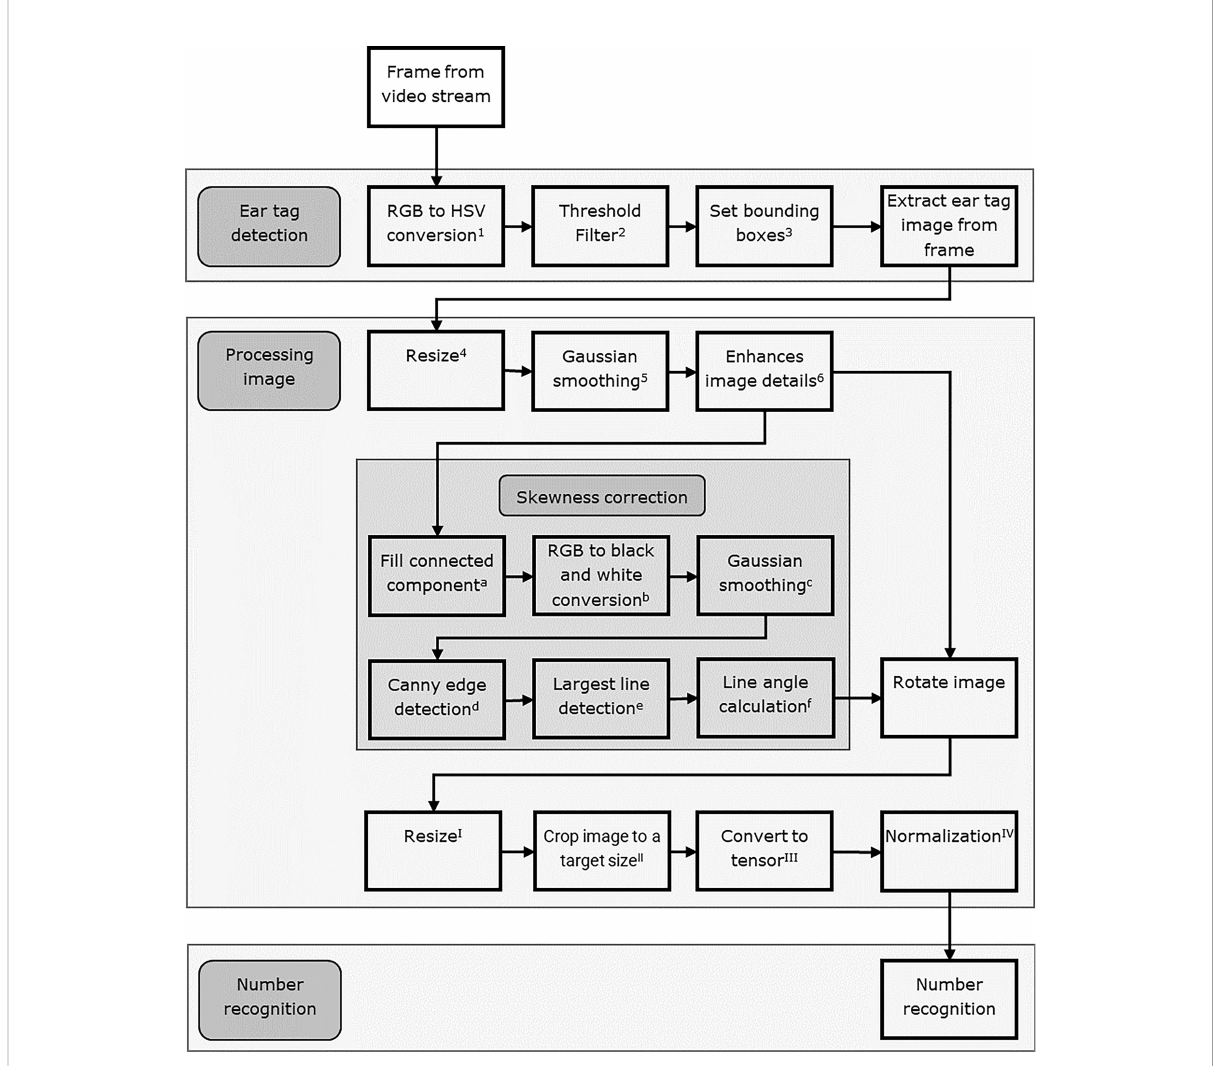
FIGURE 1 Steps in ear tag recognition algorithm. Applied functions (openCV python): 1 cvtColor(frame, cv2.COLOR_BGR2HSV), 2 inRange(frame, [22, 95, 90], [40, 255, 255]) and threshold(image, 127, 255, 0), 3 fi ndContours(frame, cv2.RETR_TREE, cv2.CHAIN_APPROX_SIMPLE), 4 resize(crop_img, dim, interpolation = cv2.INTER_LINEAR), 5 GaussianBlur(image, (5, 5), 0), 6 detailEnhance(image, sigma_s = 20, sigma_r = 0.10), a fl oodFill(image, [height + 2, width + 2], (100, 100), (0, 255, 255), (60, 60, 110), (70, 150,200), cv2.FLOODFILL_FIXED_RANGE), b cvtColor(image, cv2.COLOR_BGR2GRAY) and threshold(grayImage, 127, 255, cv2.THRESH_BINARY), c GaussianBlur(blackAndWhiteimage, (21, 21), 2), d Canny (blackAndWhiteImage, threshold1 = 20, threshold2 = 30,apertureSize = 7), e HoughLinesP(edges, 1, np.pi/180, 30, minLineLength = 50, maxLineGap = 50), f rad2deg(np.arctan2(y2 - y1, x2 - x1), I transforms.Compose([transforms.Resize([64, 64]), II transforms.CenterCrop([54, 54]), III transforms.ToTensor(), IV transforms.Normalize([0.5, 0.5, 0.5], [0.5, 0.5,